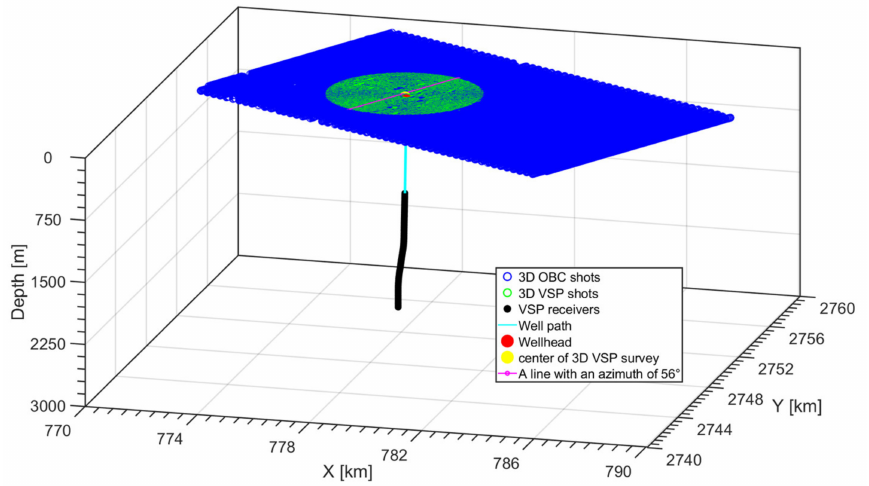
Figure 2. A basemap showing the shot positions of the 3D OBC seismic and 3D VSP surveys. In addition, also shown are the positions of the downhole receivers, wellhead and a line with an azimuth of 56 ◦ passing by the center of the VSP